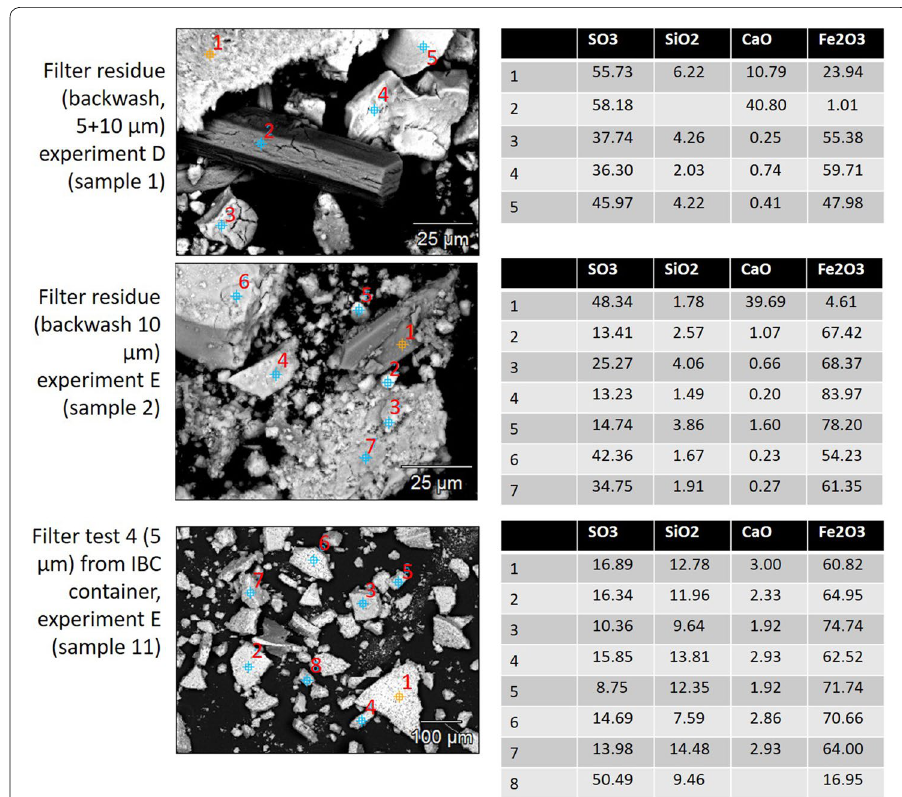
Fig. 10 SEM pictures of three samples (Table 2) together with the main elemental composition as obtained by EDX